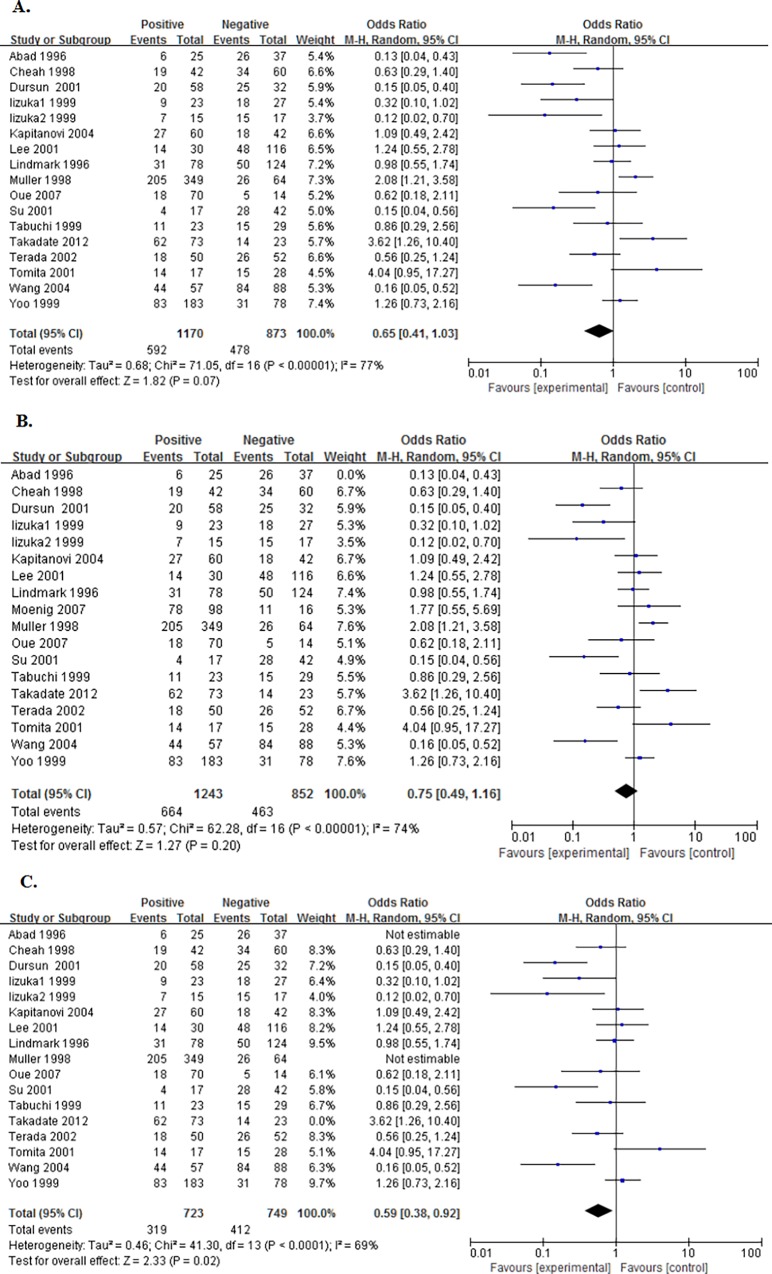
Forest plot of odds ratio (OR) for the association between NME1 overexpression and overall survival (OS) in patients with digestive system cancers with random effects model.A. The ORs for OS; B. The ORs for OS without “Abad 1996”; C. The ORs for OS without low cut-offs.